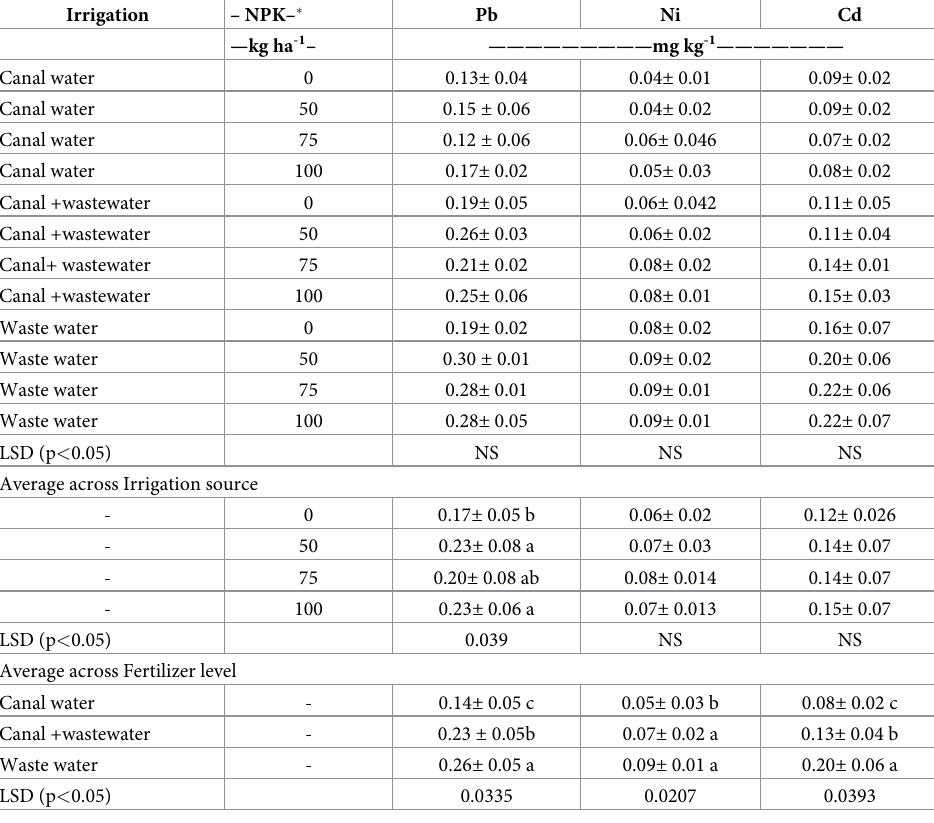
Table 5. Soil heavy metal (Pb, Ni and Cu) as influenced by NPK level and irrigation source. Irrigation – NPK– � Pb Ni Cd —kg ha -1 – —————————mg kg -1 ——————— Canal water